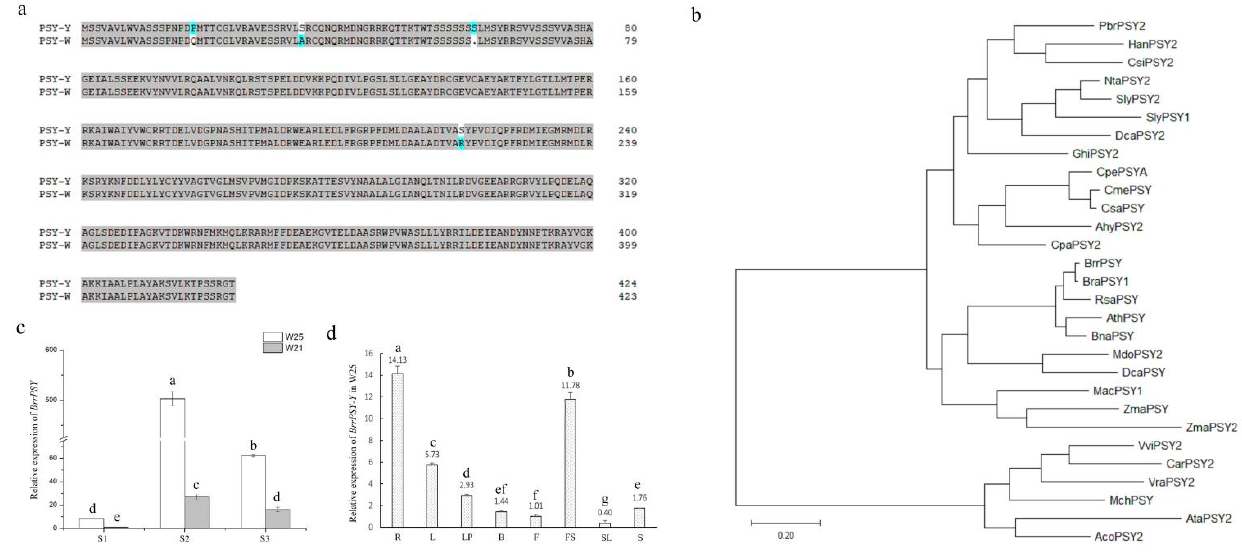
BrrPSY gene at different development stages in turnip root. ( d ) Relative expression of BrrPSY-Y gene in different tissues of turnip in yellow-fleshed W25. Lowercase letters in ( c , d ) indicate the significance